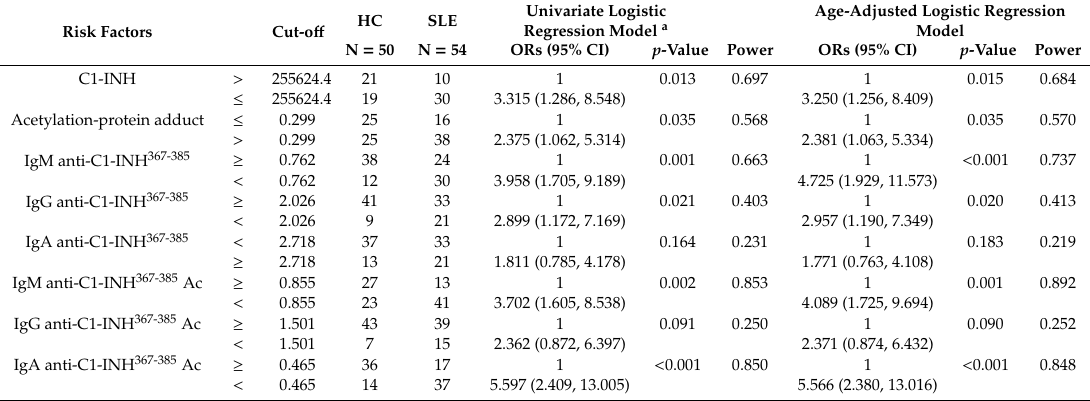
Table 1. Associations of levels of the C1-inhibitor (INH), acetylation (Ac)-protein adduct, and anti- C1-INH 367–385 and anti-C1-INH 367–385 Ac peptide autoantibody isotypes with risks of SLE development in 54 patients with systemic lupus erythematosus (SLE) versus 50 healthy controls (HCs). Age-Adjusted Logistic Regression Risk Factors Cut-off HC SLE Univariate Logistic Regression Model a Model N = 50 N = 54